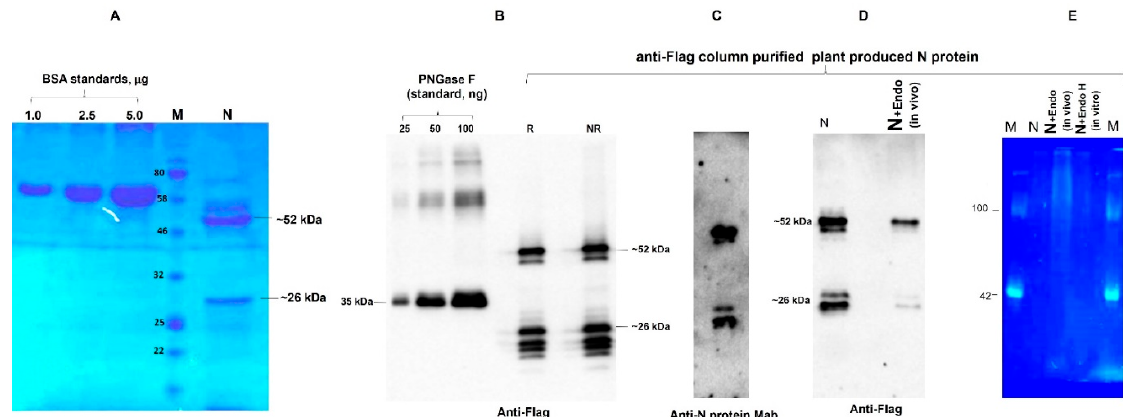
Figure 1. SDS-PAGE ( A ), Western blot ( B – D ), and glycan detection ( E ) analysis of purified plant-produced N protein. N protein from N. benthamiana plant was purified using anti-FLAG antibody resin. Membranes were probed with anti-Flag ( B , D ) or anti-N protein monoclonal antibody (human novel coronavirus nucleoprotein, 1–419 aa, monoclonal antibody, ( C )). ( A ) Anti-FLAG antibody resin-purified N protein was analyzed by SDS-PAGE. N: 2 μ g of plant-produced, purified N protein was loaded into a well. BSA standards: 1.0, 2.5, and 5.0 μ g of BSA protein was loaded as a standard protein. M: color pre- stained protein standard (NEB, Ipswich, MA, USA). ( B ) Plant-produced N protein was run in reducing (R) or nonreducing condition (NR). Lanes: 25, 50, and 100 ng of plant-produced PNGase was loaded as a standard protein. ( C ) Anti-Flag column- purified N protein was analyzed by Western blot analysis using anti-N protein mAb. ( E ) Glycan detection analysis of anti- Flag purified N protein (N) in vivo co-expressed with Endo H (N + Endo H, in vivo). M—CandyCane glycoprotein molecular weight standards (Molecular Probes), 250 ng of each protein per lane. ( D )) Western blot analysis of the same sample using